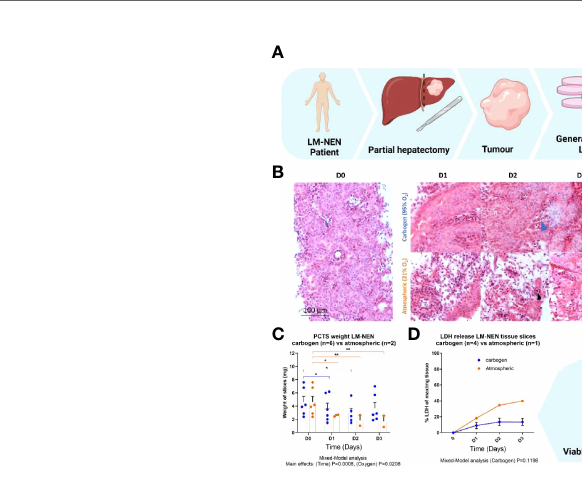
FIGURE 1 | Precision cut tissue slices from LM-NEN require carbogen for tissue preservation beyond 3 days. (A) Schematic overview of experimental design. (B) Representative images of H&E staining of LM-NEN PCTS cultured in carbogen or atmospheric oxygen (n patients =3). Tumour stroma is highlighted by blue arrows. Areas of necrosis (green arrows) and apoptosis (black arrows) are magni fi ed. (C) PCTS weight (in mg) was measured daily, each point represents a different patient and is the average of 3 technical replicates (slices), (n patients indicated; *P ≤ 0.05, **P ≤ 0.01). (D) Normalised lactate dehydrogenase release (LDH) detected in PCTS culture supernatant. Each point is the mean ± SD of 3 supernatants per patient (n patients indicated). Created with